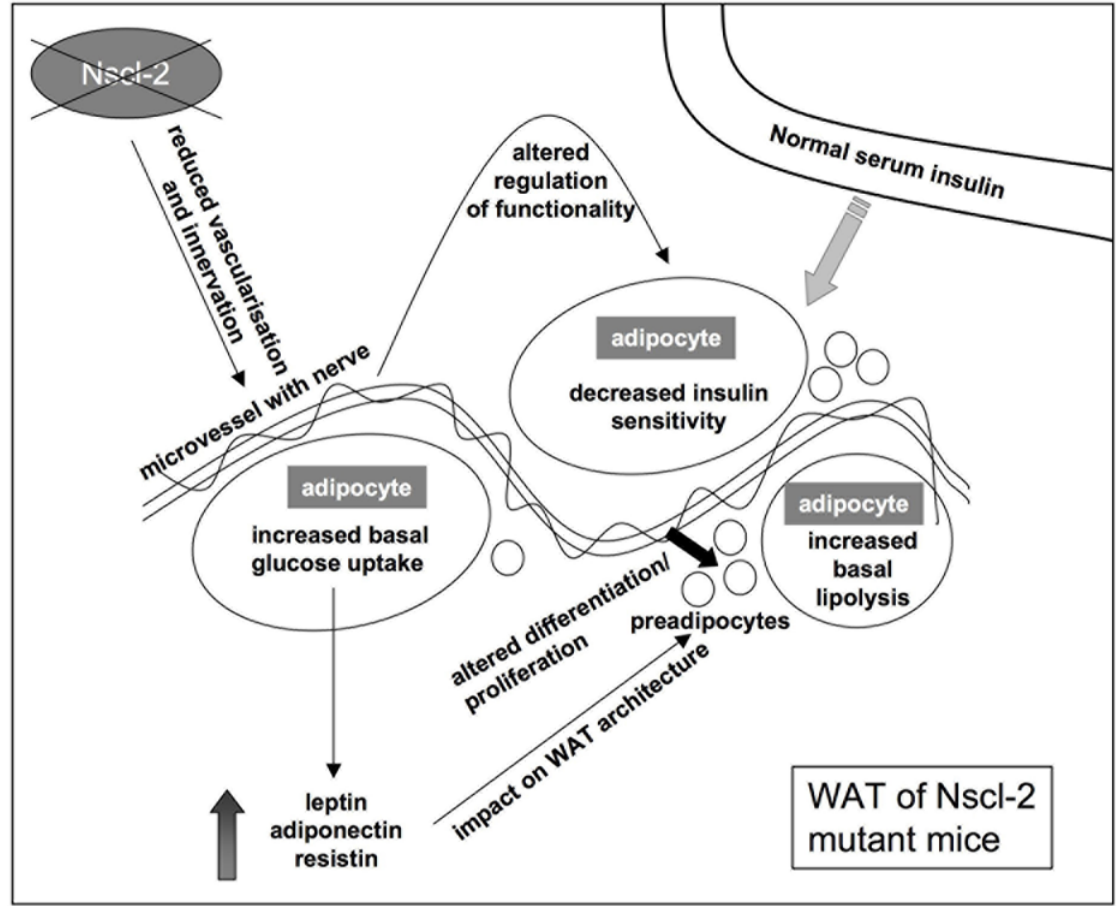
Figure 9. Putative model of the impact of Nscl-2 controlled mechanisms on WAT. The lack of Nscl-2 results in reduced innervation and vascularization of WAT, which most likely leads to accumulation of preadipocyte/macrophage-like cells and the bimodal distribution of the size of adipocytes in WAT. The altered functionality of adipocytes is reflected by decreased insulin sensitivity, increased basal glucose uptake, and increased basal lipolysis. The decreased insulin sensitivity of isolated adipocytes seems to be compensated by other tissues, which might explain the relatively normal serum insulin concentrations.